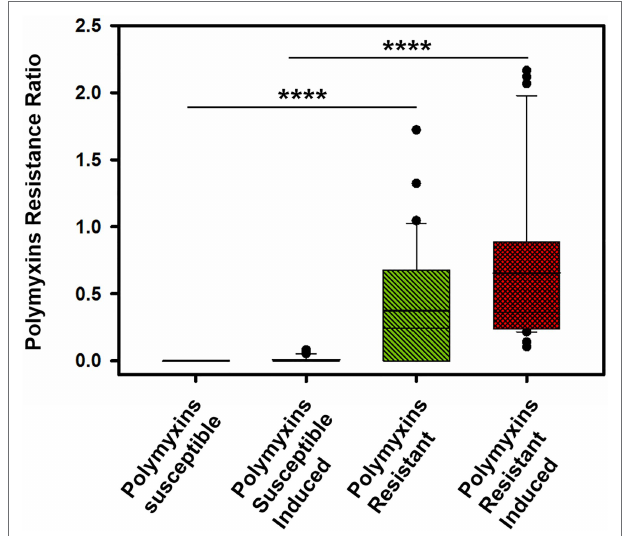
FIGURE 3 | Distribution of the Polymyxin Resistance Ratios (PRRs) for the tested strains before and after induction with colistin for 4-h to a subinhibitory (1/2 MIC; **** p <